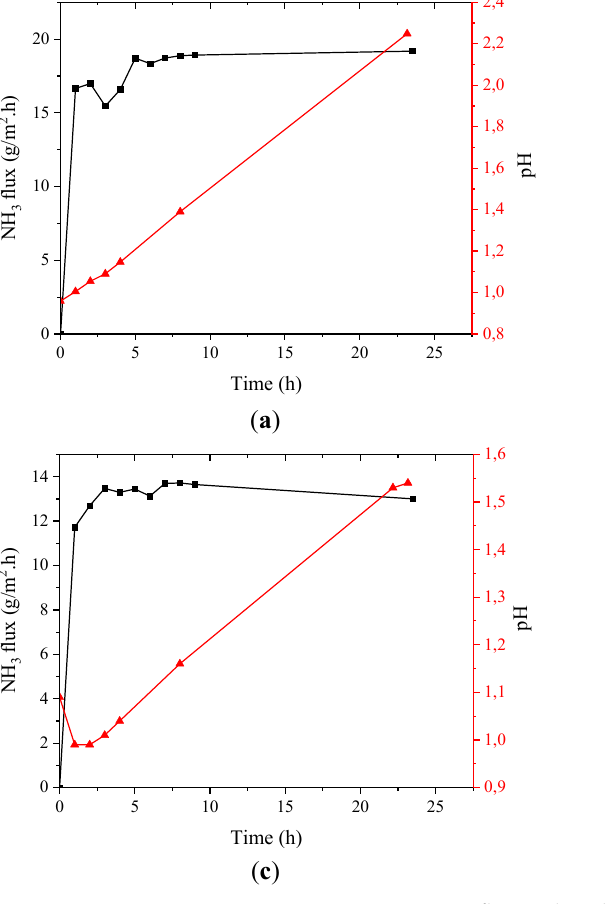
Figure 4. Mass transfer coefficient of tested membrane fibers using a synthetic ammonia solution. 3.2. Ammonia Recovery from Landfill Leachate: Lab Scale vs. Pilot Scale The ammonia concentration profile for the inlet, outlet, and acid tank of the pilot reactor is shown in Figure 5. The fluctuations in the inlet concentration reflect the variation in the ammonia concentrations of the produced leachate at the Ämmässuo site, as the re- actor was connected directly to the source point of the collected leachate without a pre- treatment step. It can be seen that the reactor was efficient at recovering ammonia from